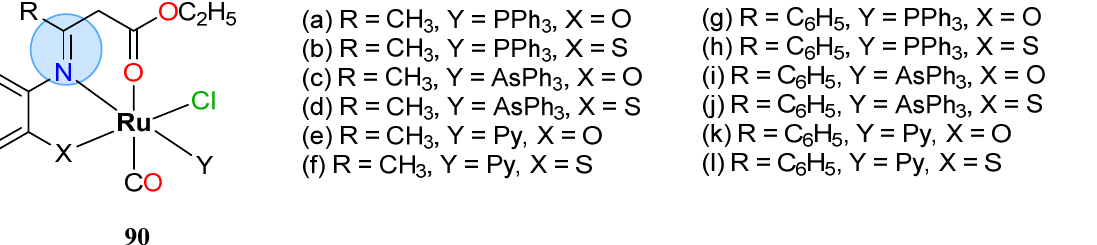
Figure 47. Diamagnetic ruthenium(II) complexes with monobasic tridentate Schiff base ligands derived from o ‐ aminophenol or o ‐ aminothiophenol.